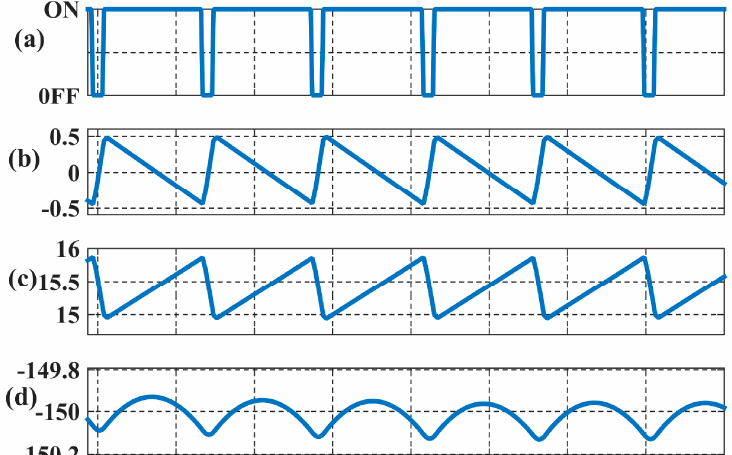
Figure 11. Output voltage and current ripple transients. ( a ) Gate Signal; ( b ) Control Signal (u); ( c ) Input current; ( d ) Output voltage ( V o Input current; ( d ) Output voltage ( V o ).